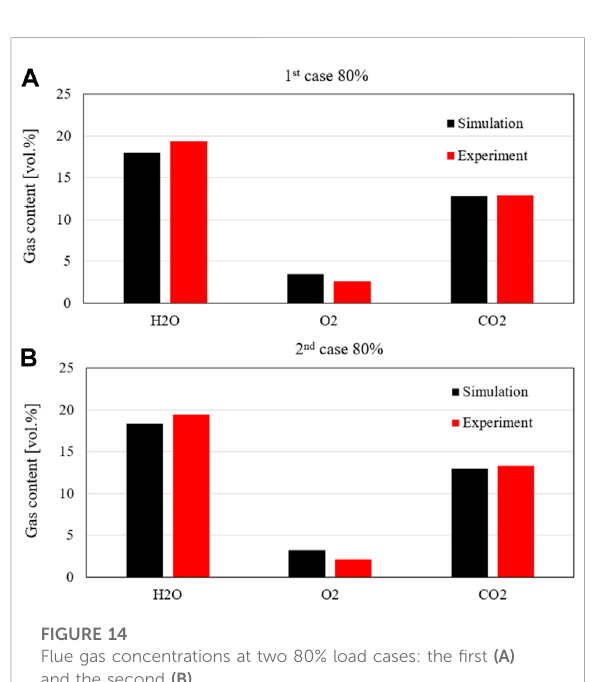
FIGURE 14 Flue gas concentrations at two 80% load cases: the fi rst (A) and the second (B) .